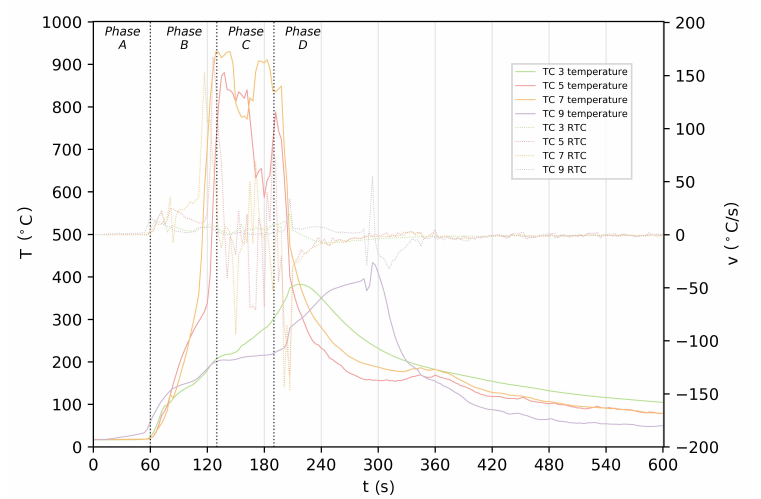
Figure 5. Temperature and RTC readings of thermocouples TC2, TC4, and TC8 during the first 600 s of the test. Phases A, B, C, and D according to Table 2 and Figure